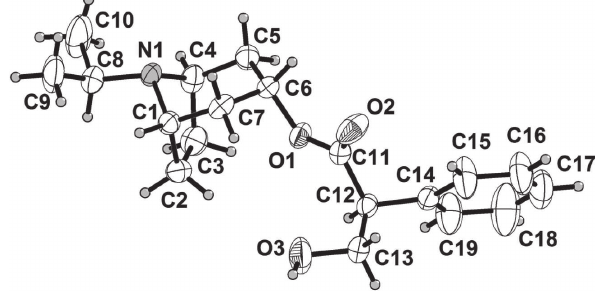
Table 1: Data collection and handling.